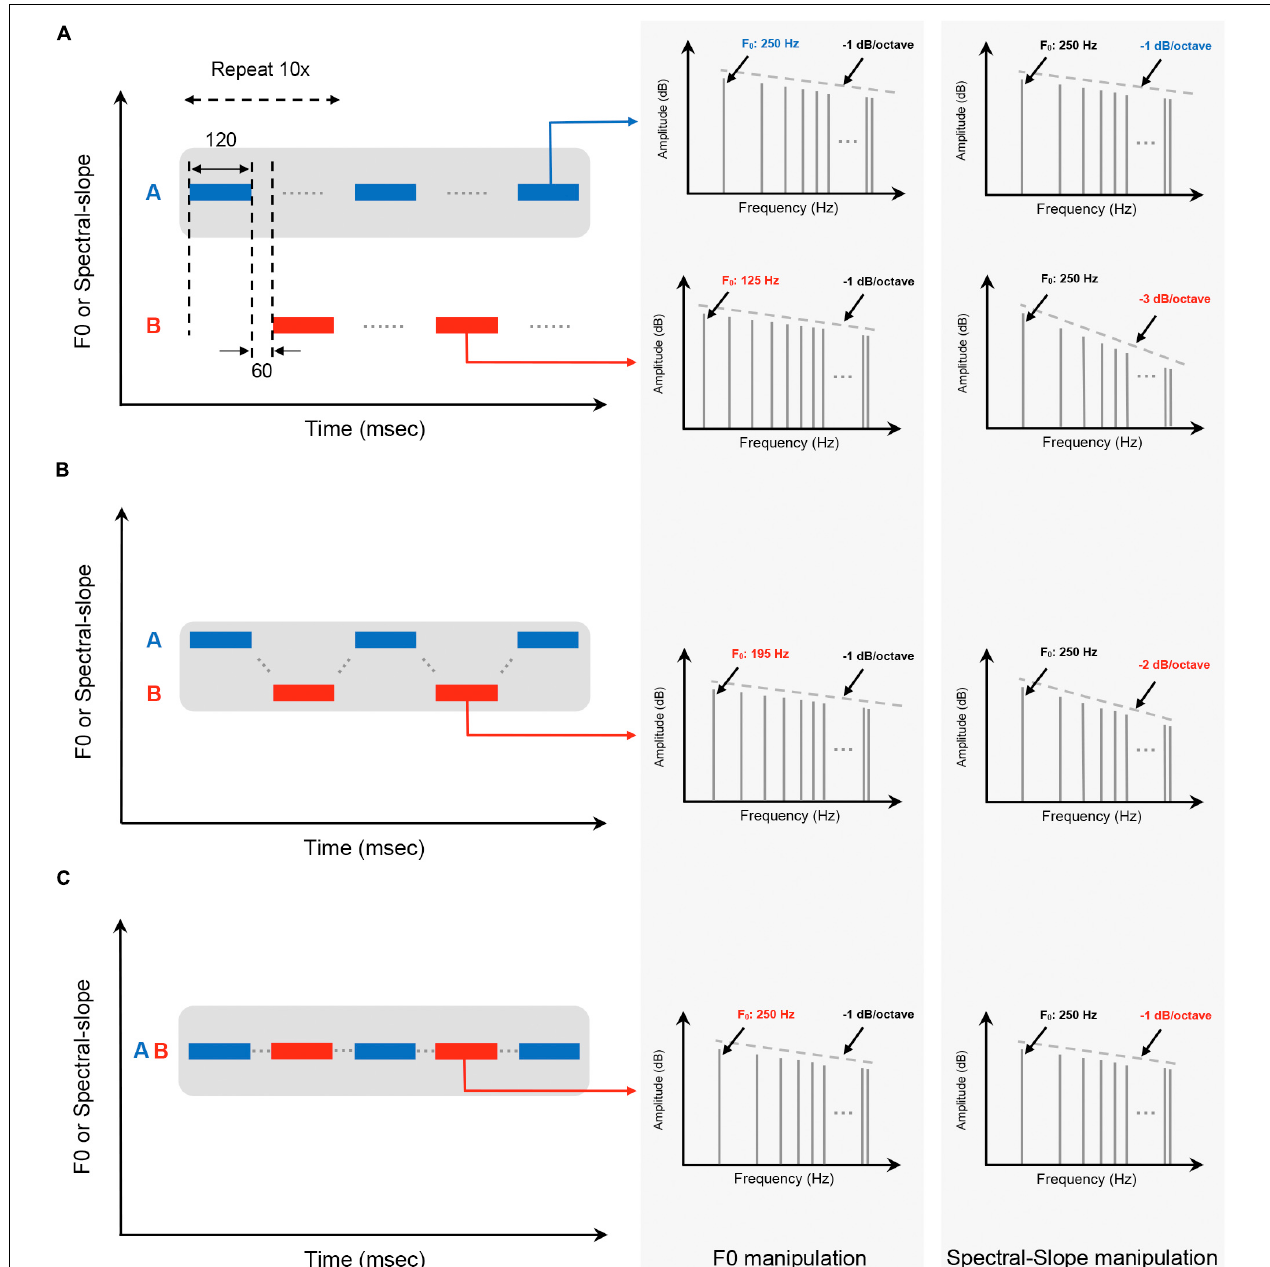
FIGURE 1 | Schematic of stimuli used in the auditory grouping range measurement with example stimuli for (A) “two streams” perception, (B) “ringing” perception, and (C) “even” perception. Gray shaded areas in (A–C) indicate the boundaries of the grouping range around the stimulus A. The right two columns represent example harmonic stimuli of each percept in the F0 domain and the spectral slope domain. The F0 and spectral slope of each stimuli are also indicated.